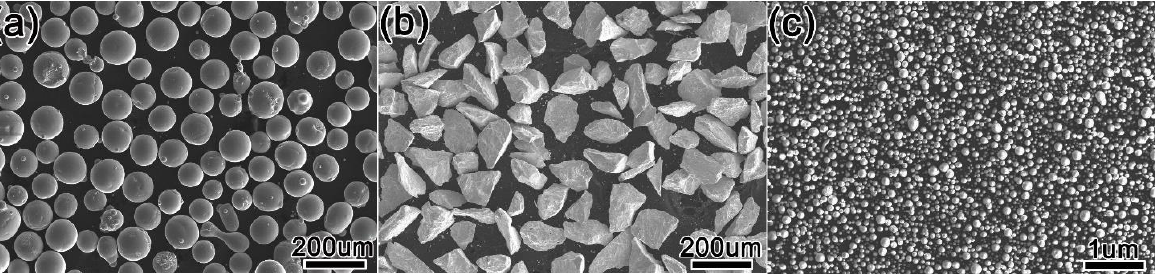
Figure 1. Morphology of the three powders ( a ) Ni60, ( b ) WC, and ( c ) Nano-Y 2 O 3.